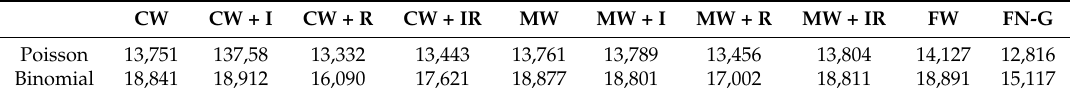
Table 5. Number of